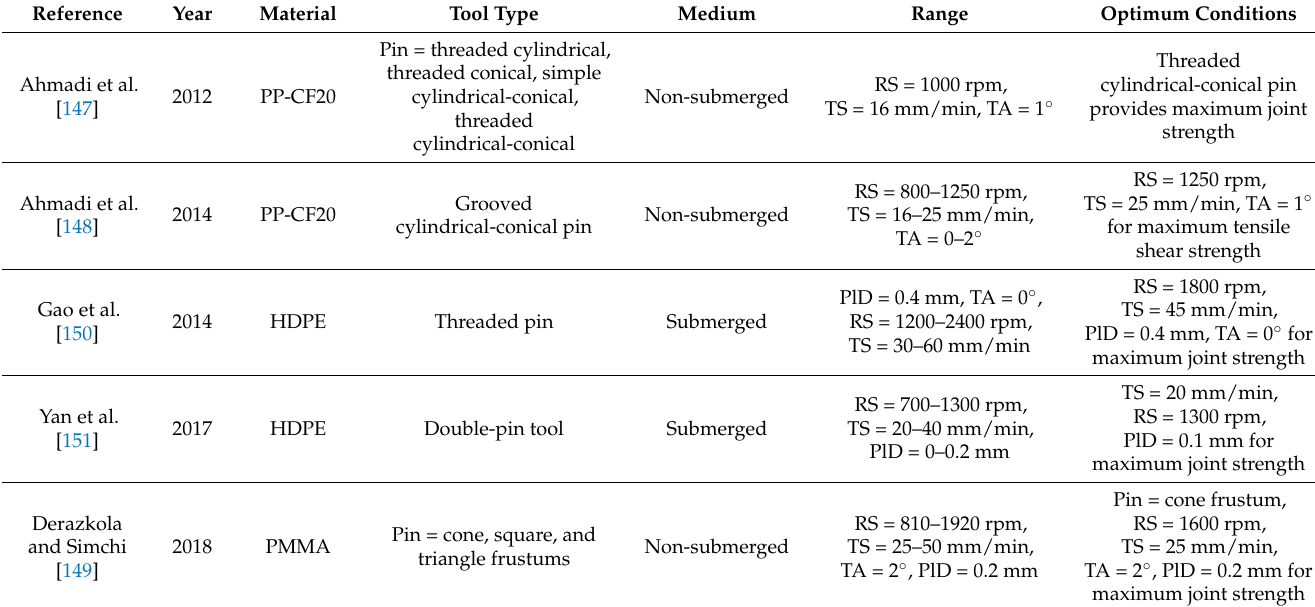
Table 6. Lap-joint friction stir welding of thermoplastic polymers and polymer composites